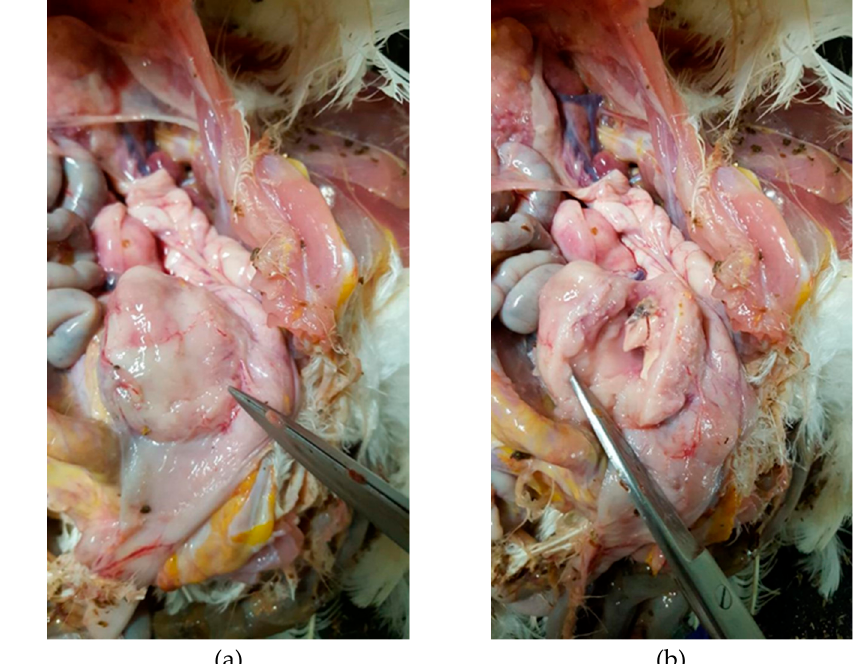
Figure 1. Tumor mass under the cloaca ( a ); internal part of tumor ( b ).